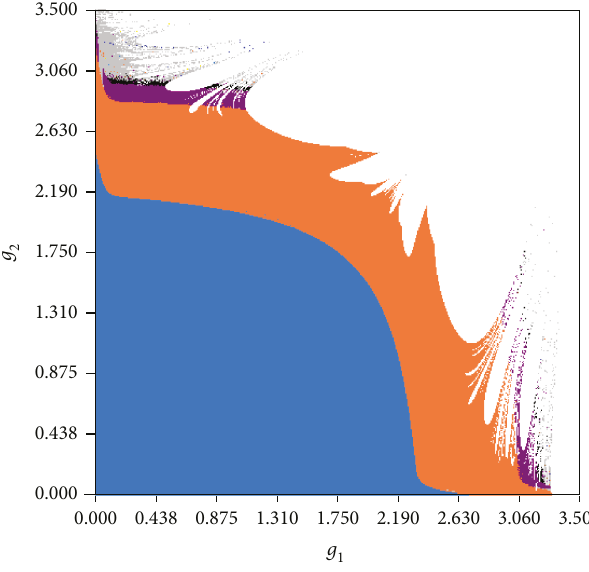
Figure 4: 2D bifurcation diagram of g